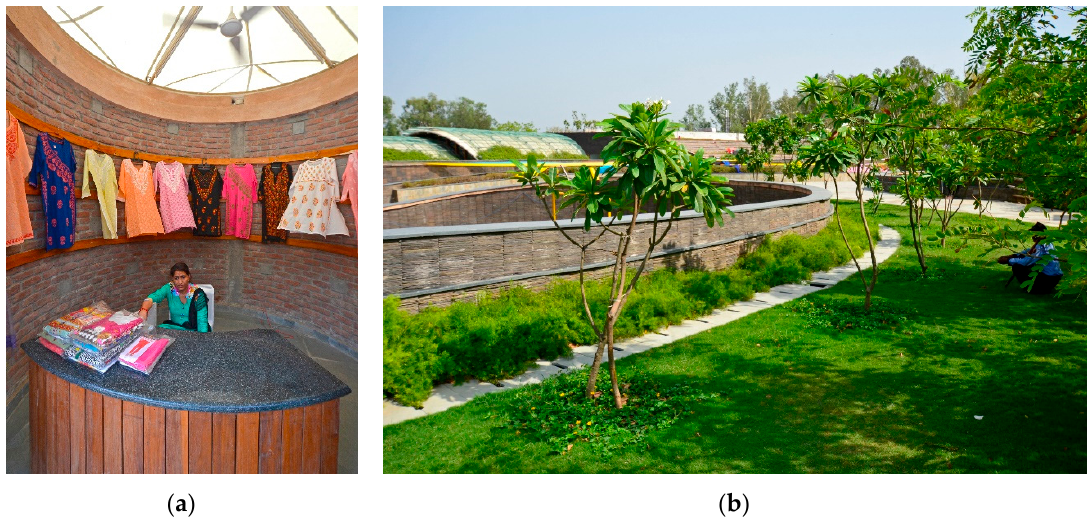
Figure 34. ( a ) Tensile canopies with ceiling fans cover the craft shops; ( b ) large usable green roofs above air-conditioned shops (Photos: Author).